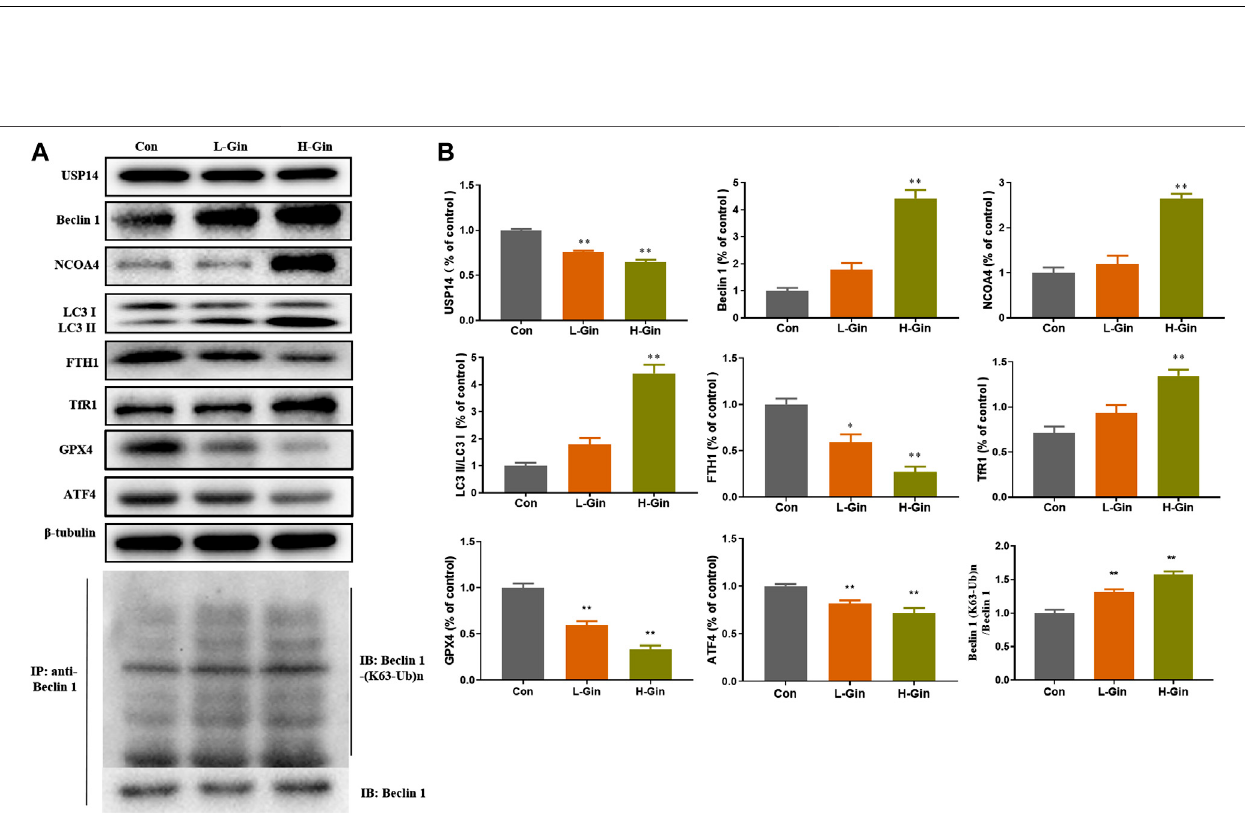
Frontiers in Pharmacology |